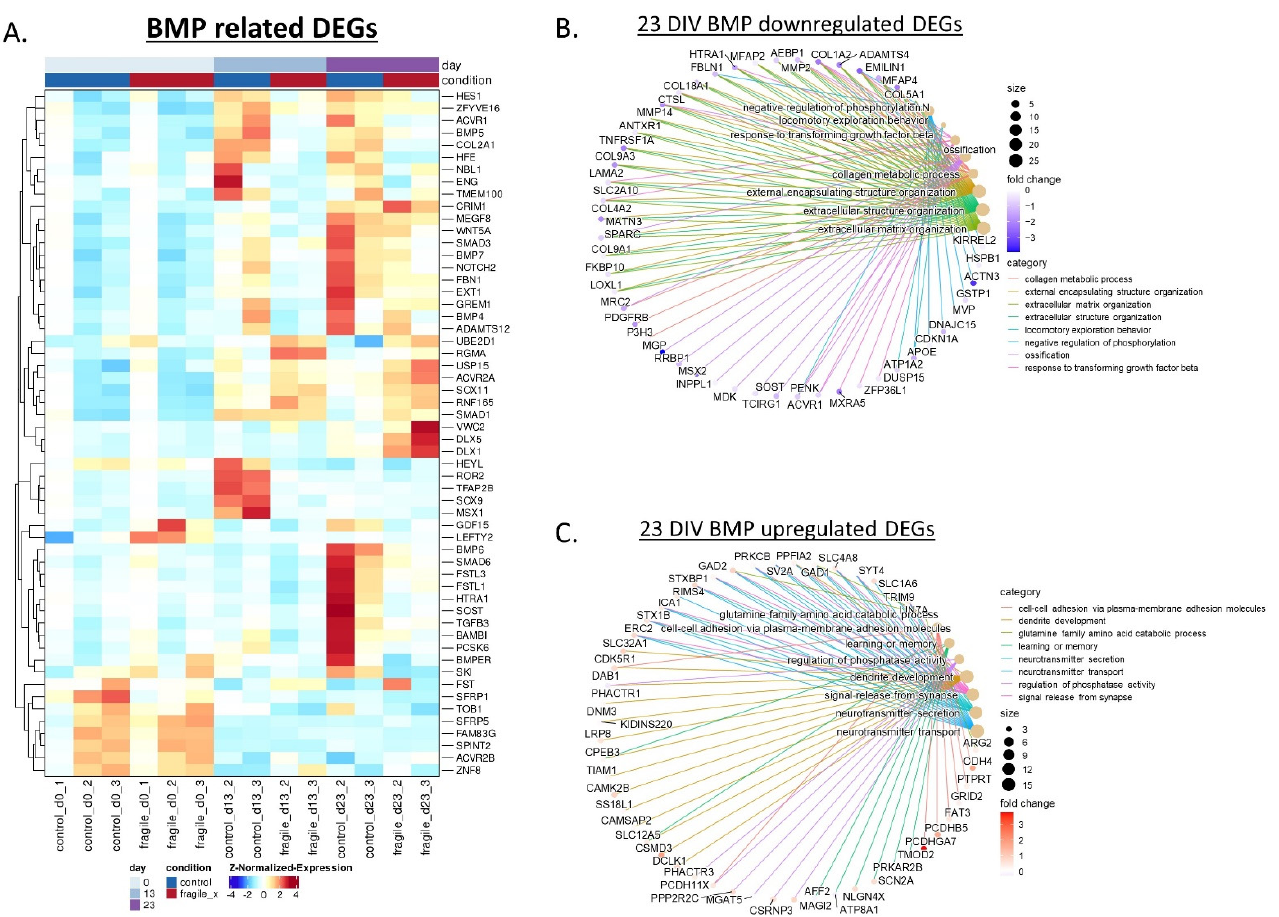
Figure 4. BMP related genes are involved in the altered differentiation of FX neurons. ( A ) Heatmap of DEGs related to the BMP pathway during neuronal differentiation of FX- and isogenic control-hESCs (13 and 23 DIV). Columns represent samples and rows represent genes, categorized into clusters of common expression patterns. The heatmap illustrates lower (blue) to higher (red) gene expression levels. ( B ) A GO enrichment plot of 23 DIV downregulated DEGs, with a focus on BMP. ( C ) A GO enrichment plot of 23 DIV upregulated DEGs, with a focus on BMP.